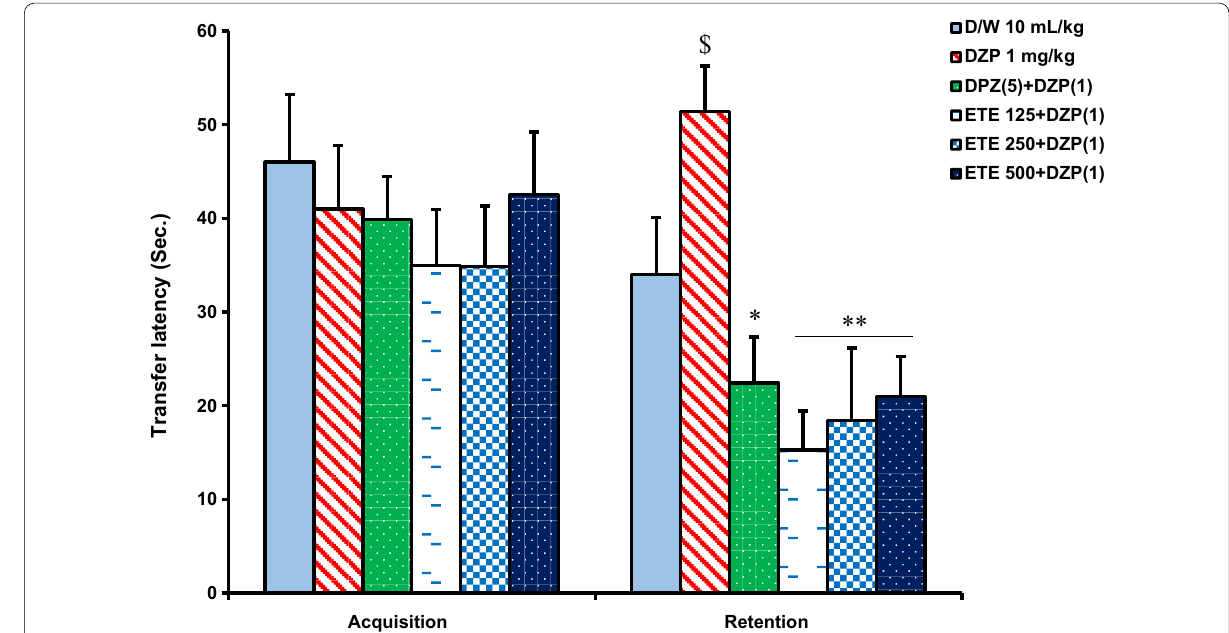
Fig. 3 Effect of Eragrostis tremula extract (125, 250 and 500 mg/kg) on transfer latencies of mice on elevated plus maze following diazepam-induced amnesia. Values are Mean alone group—one-way ANOVA followed by Bonferroni’s test, n